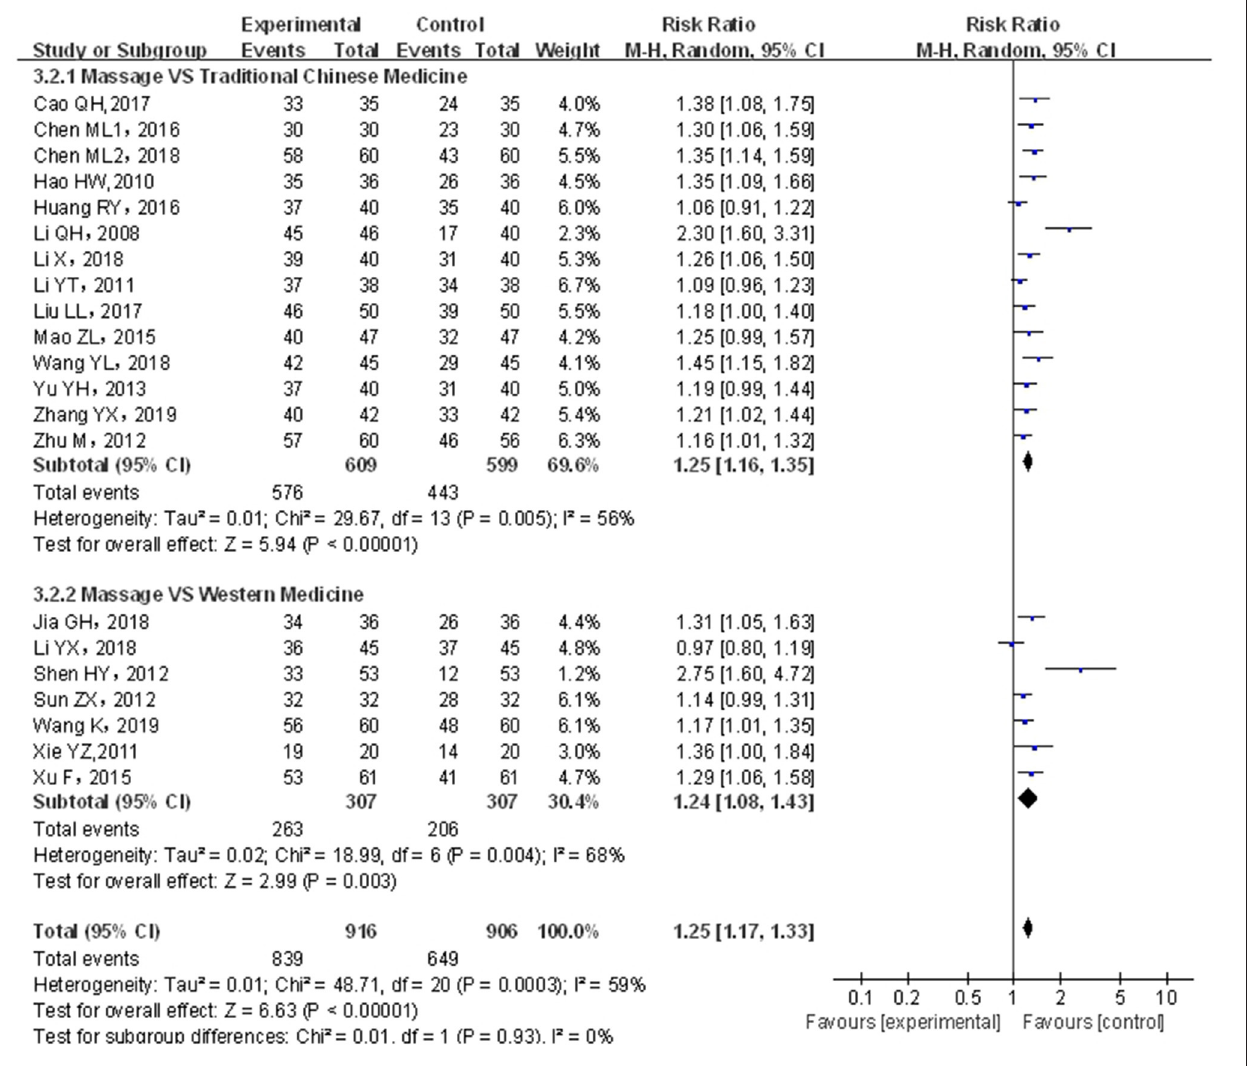
FIGURE 4 | Meta-analysis of infant massage and drug therapy in the treatment of children with functional constipation.